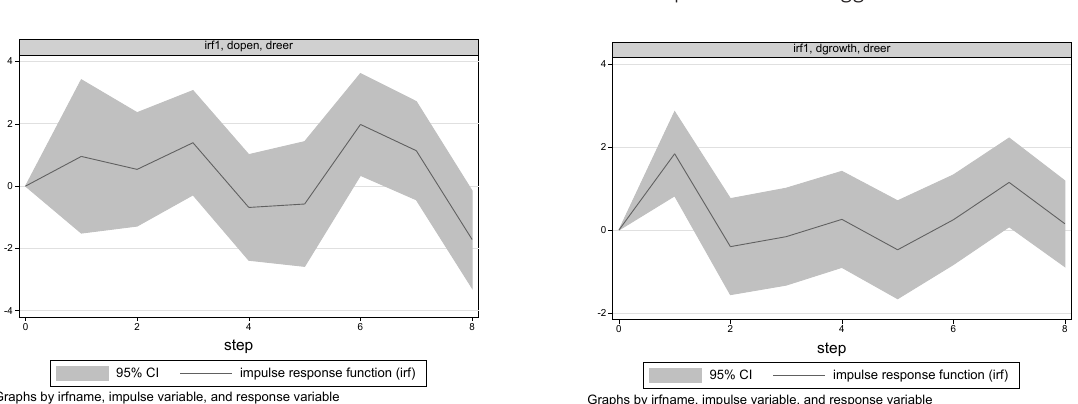
Response of FDI to